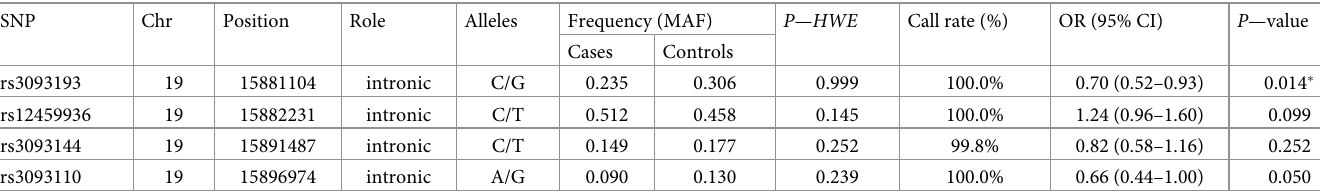
Table 4. Basic information and allele frequency of the selected SNPs in CYP4F2